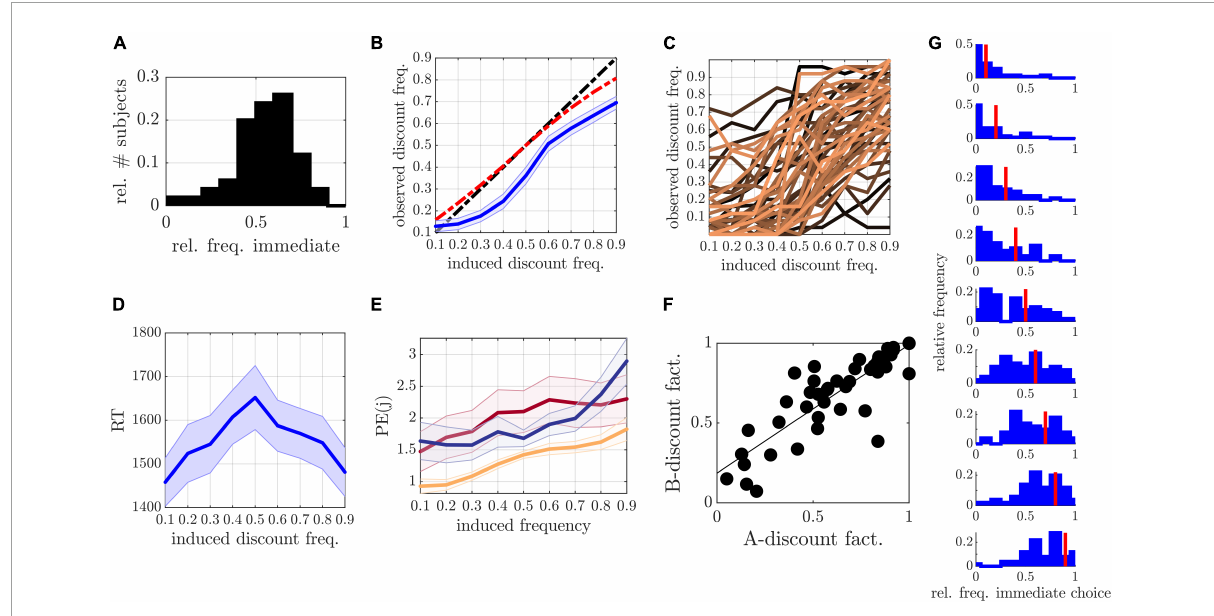
FIGURE3 (A) Relative frequency of immediate choices in run A. (B) Relative frequency of discounted choices ( y -axis) as a function of model induced frequencies ( x -axis) averaged over all participants (mean and SEM are displayed in blue). The black dashed line marks the identity, while the red dashed line shows the actual predicted frequencies according to the models. (C) Single participant curves. (D) Mean and SEM of reaction time (RT) as a function of experimental conditions. (E) Mean and SEM of prediction error (PE) as a function of experimental conditions for modified hyperboloid (yellow), hyperbolic (red), and hyperboloid control (blue) models. (F) Discount factor in run A ( x -axis) and run B ( y -axis) illustrated for delay = 90, indicating a reliable estimate of discounting across runs. (G) Histograms of immediate choice behavior for 0.1 (top) to 0.9 (bottom) frequency conditions (conditions indicated by the red